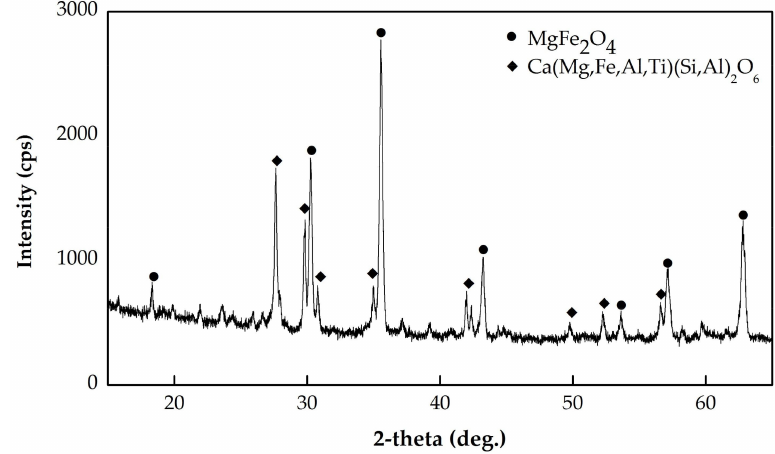
Figure 4. X-ray diffraction patterns of the extracted